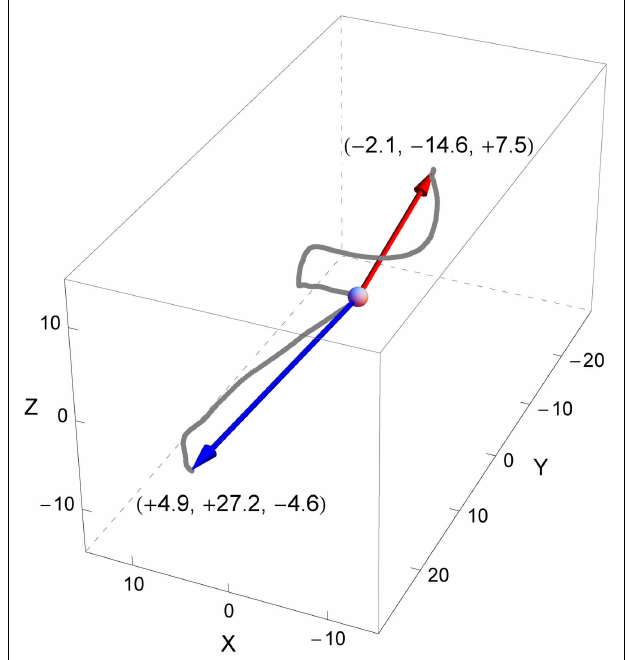
FIGURE 2 |An example of a participant’s head rotations during two trials (red for one trial, blue for another), represented in the space of rotations. The deviation angles in both trials had the same absolute value of 135˚ but opposite signs (positive for the red trial, negative for the blue). The curves are constituted of dots that represent the terminal points of all rotation vectors (axis-angle representation) computed for each sample of the trials.The origin of the rotation space (corresponding to the initial orientation of the head at the beginning of each trial) is depicted by the gray sphere.The arrows represent the maximum rotation vectors of the head for each trial. Each arrow represents the axis of rotation (by its orientation), the direction of rotation (by its sense), and the angle or amplitude of rotation (by its length). Note that in our example the rotation axes of both trials have about the same direction but opposite signs denoting that in both trials the head has rotated around roughly the same axis but in opposed directions. Here, the main component of the rotation is about the Y axis, which suggests a rotation similar to a head roll, inclining the head to the left for the positive deviation angle (red trial) and to the right for the negative deviation angle (blue